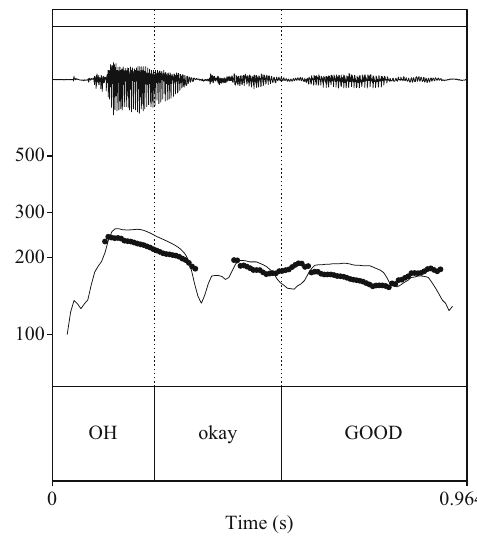
Figure 4: Pitch trace and intensity curve for line 25 in Ex. ( 8 ) “ Moving ”